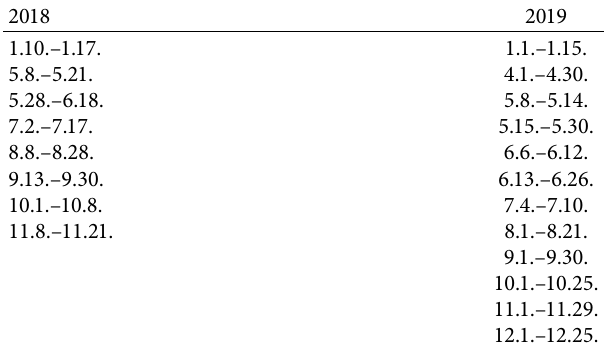
Table 3: The coupon strategies time provided by the platform.